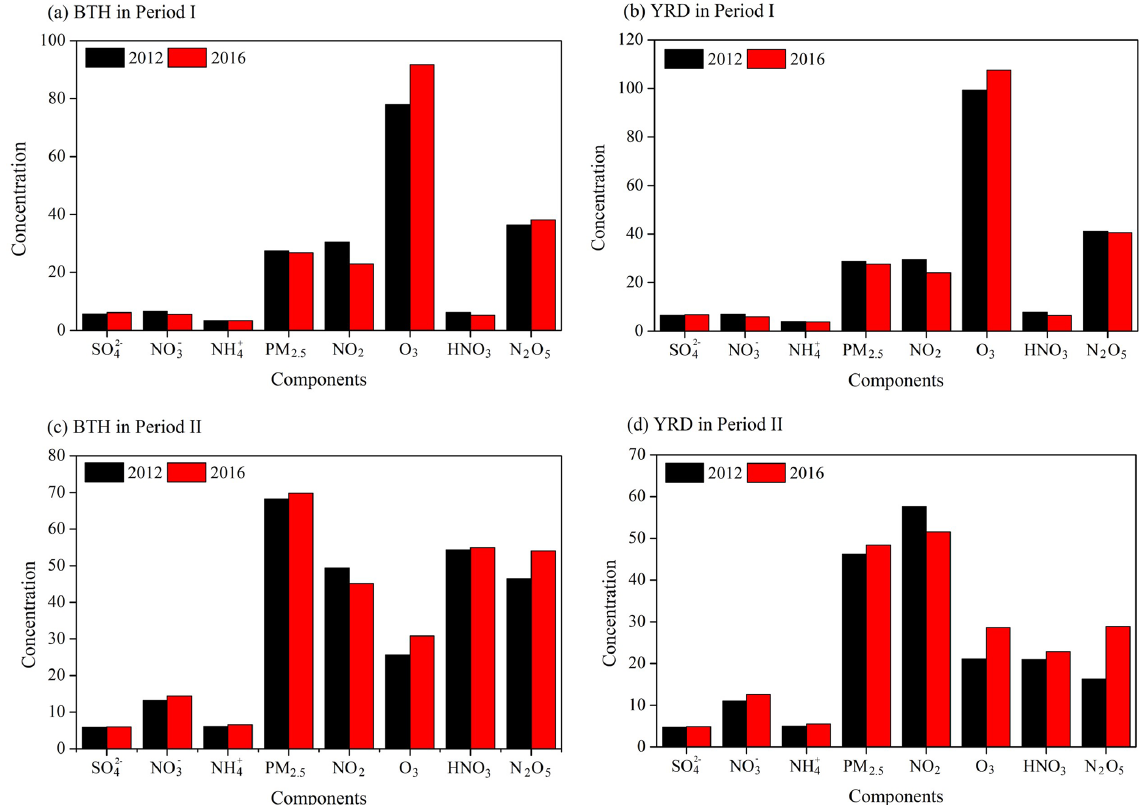
Figure 11. Changes in the concentrations of surface PM 2 . 5 , SIA components and key atmospheric trace (NO 2 , O 3 , HNO 3 and N 2 O 5 ) due to the 2012–2016 NO x emission reductions in China, estimated as the differences between the base simulation and the E1 scenario. The units are parts per trillion (ppt) for HNO 3 and N 2 O 5 and micrograms per cubic meter (µgm − 3 ) for other chemical species.